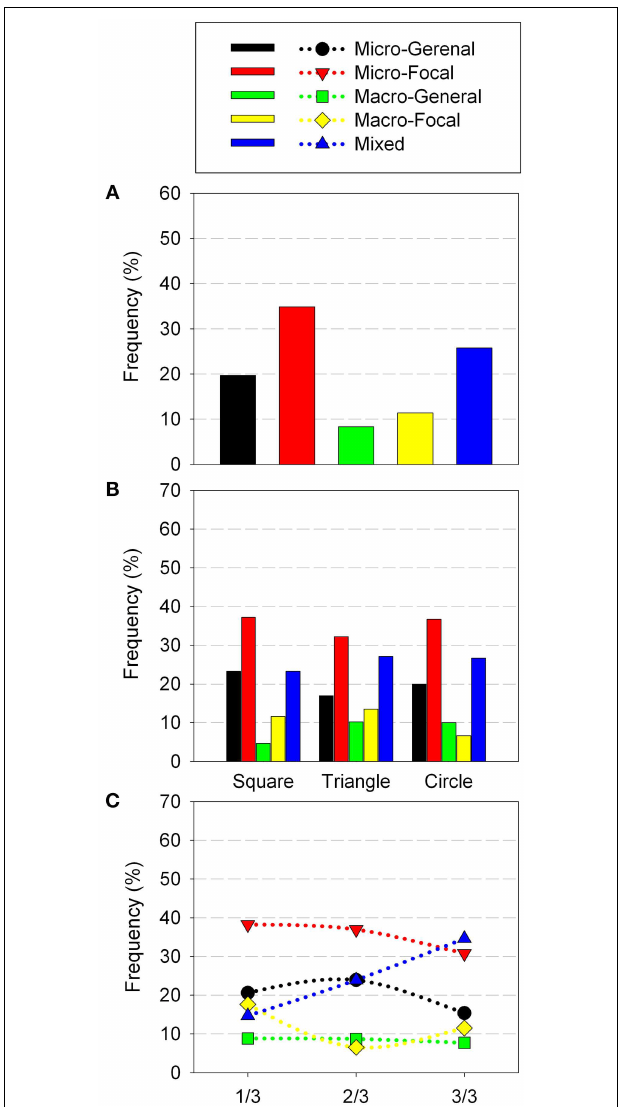
FIGURE 8 | Sensorimotor Strategies distribution in Experiment 3 according: general use (A) geometric shape (B) and trial order (C). The figures report the cumulative percent of strategies of all